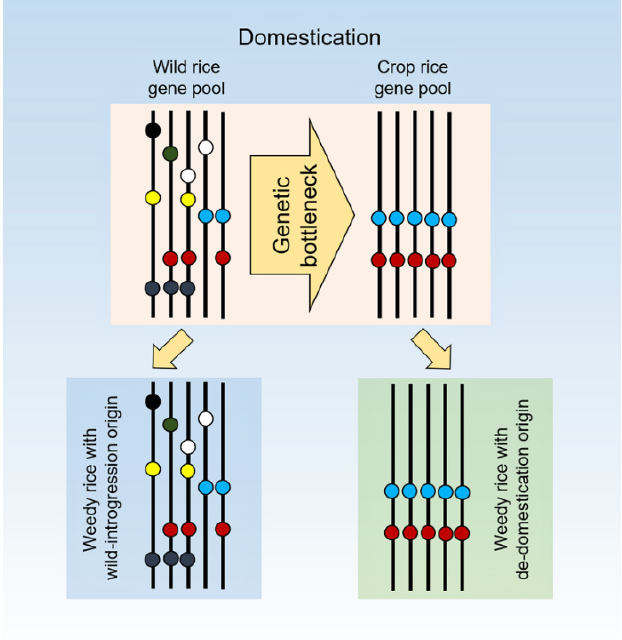
Figure 1. Hypothetical illustration indicating substantial reduction of single nucleotide polymor- phisms (SNPs) at a DNA fragment of a candidate gene and its flanking regions from wild rice (top- panel, left) to crop rice (top-panel, right) gene pools, due to genetic bottlenecks in domestication. Consequently, weedy rice populations that evolved directly from wild rice (wild-introgression, bottom panel, left) should have a much greater level of SNPs than those that evolved from crop rice (de-domestication, bottom panel, right). Circles coded with colors represent different genotypes. Adapted from Ross-Ibarra et al. [30].